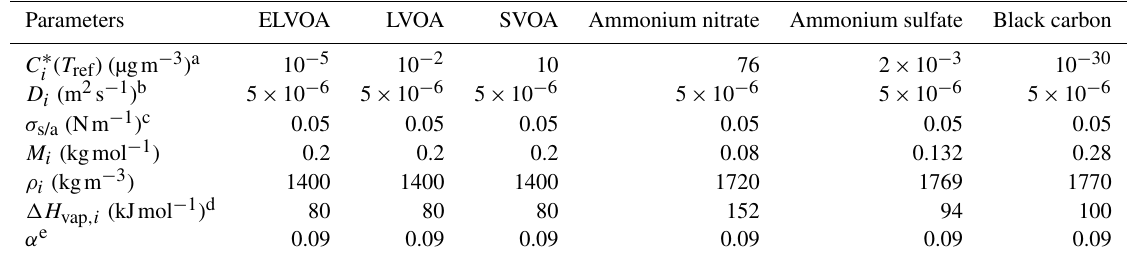
Table 2. Thermophysical properties of each component used in the multi-component evaporation dynamics model. Parameters ELVOA LVOA SVOA Ammonium nitrate Ammonium sulfate Black